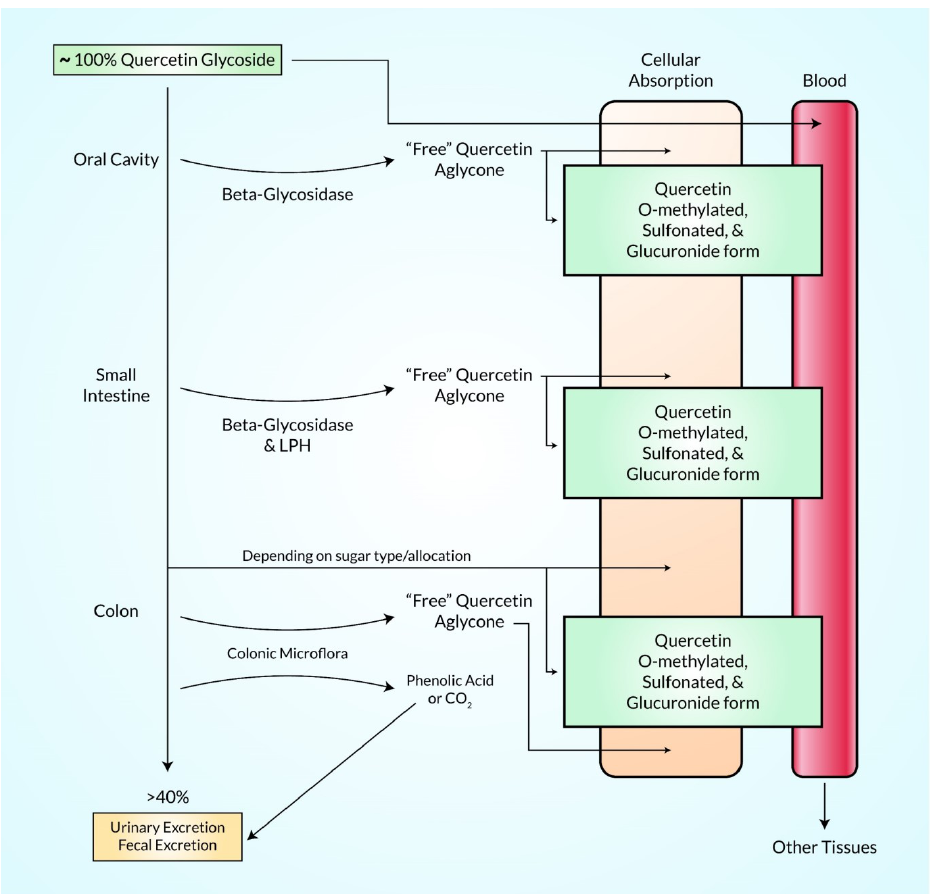
Figure 5. Illustration of possible pathways by which QC is absorbed, digested, metabolized, and excreted within body. Typically, QC glycoside is ingested orally, and partially digested in the oral cavity, surplus QC is then digested, and absorbed at multiple sites in GI tract. QC undergoes mod- ification, and then enters the circulatory system in a conjugate form. The circulatory system delivers QC to other tissues in mostly conjugated forms, and once QC reaches the target tissues it can likely be converted back into the parental compound. Quercetin has anti-inflammatory activity that pulls out the nitric oxide, catalase, and cytokines, specifically TNF- α, IL - β, and IL-6, which are inflammatory mediators, and in the promoter region of pro-inflammatory genes which is transcribed by NF- κB transcrip- tion factor where the TNF- α induced is collected and the quercetin inhibits the expression of the genes and interrupts the lipid peroxidation or poly-unsaturated fatty acid that in- creases cancer propagation by prohibiting the enzyme lipoxygenase [124]. Human body cells have many defense mechanisms such as endogenous antioxidants such as SOD, PRX, GPX, CAT, glutaredoxins, and so on, detoxifying enzymes, non-enzymatic scavenger mol- ecules (e.g., glutathione) protect the body cell from damage and are involved in repairing mechanisms [8]. It acts as an unstable free-radical scavenger named antioxidant which